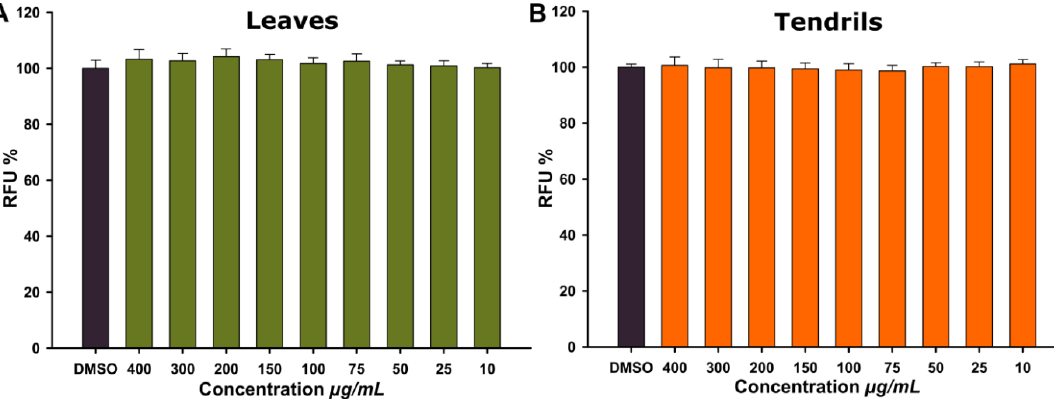
Figure 1. Cytocompatibility of the LE ( A ) and TE ( B ) observed using Alamar Blue assay on human gingival fibroblasts (HGF). The results are expressed as relative means ± standard deviations (six technical replicates for each of the three biological replicates) where the negative control (DMSO 0.2%) is 100%.